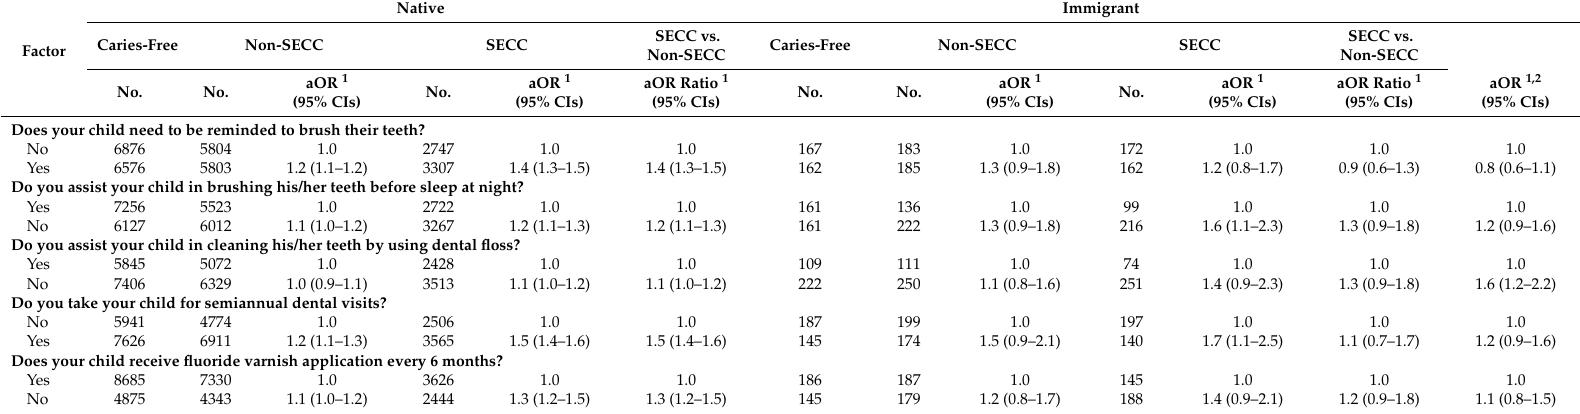
Table 4. Adjusted odds ratios of dental caries status associated with dental caries preventive behaviors in native and immigrant